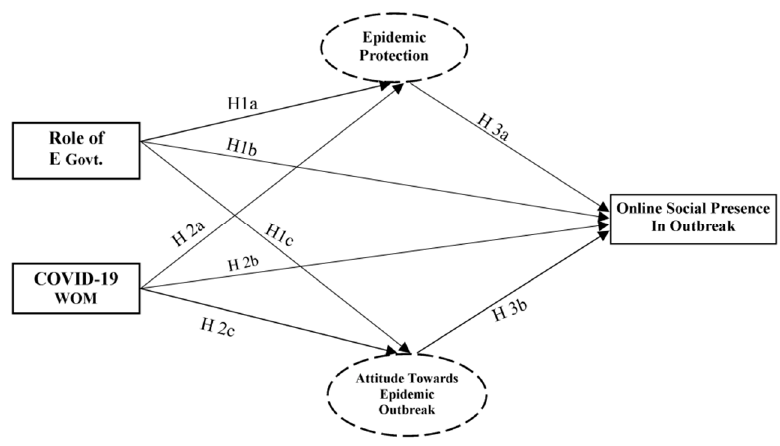
Figure 1. Conceptual model.